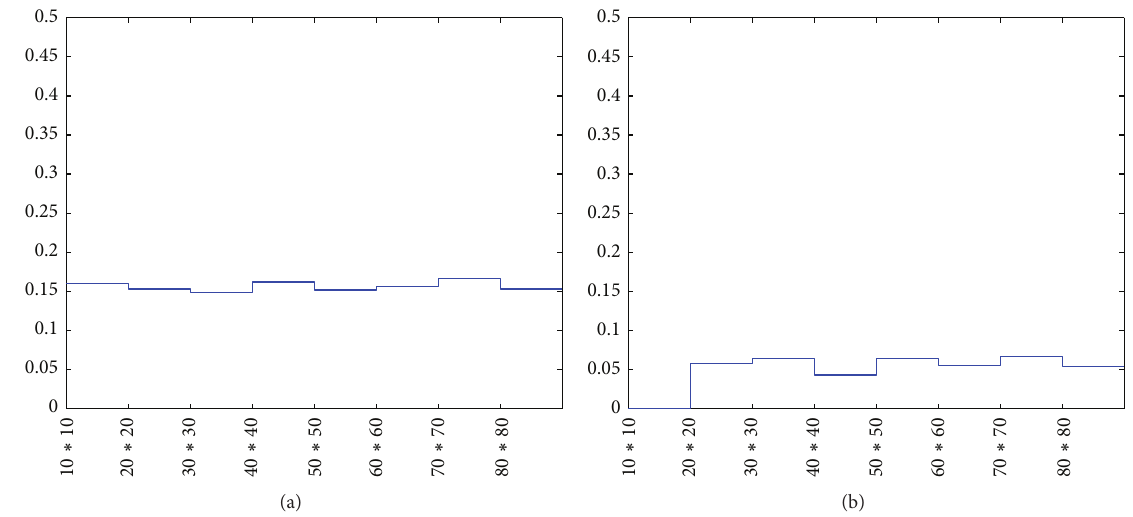
Figure 7: Simulation results on square lattices in different sizes with von Neumann neighborhood and 𝑓(0) = 0.50 . The 𝑥 -axis represents the lattice size, and 𝑦 -axis represents the frequency of cooperators in the final pattern. The results in (a) are performed by the parameters region > 𝑢 2 ,𝑢 2 < 𝑢 3 , 𝑢 3 < 𝑢 4 } , and the results in (b) are by the region {𝑢 1 {𝑢 1 0 1 0 1 0 1